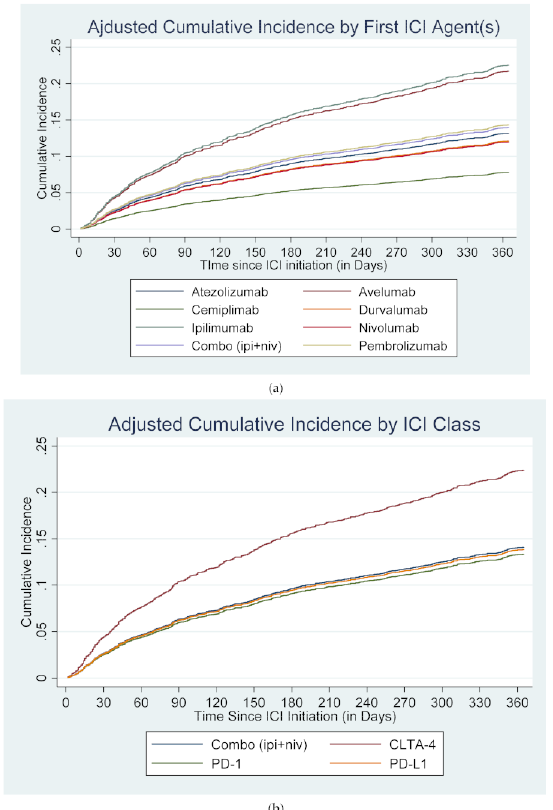
Figure 2. Cumulative incidence of cardiotoxicity after competing risk regressions, adjusted for